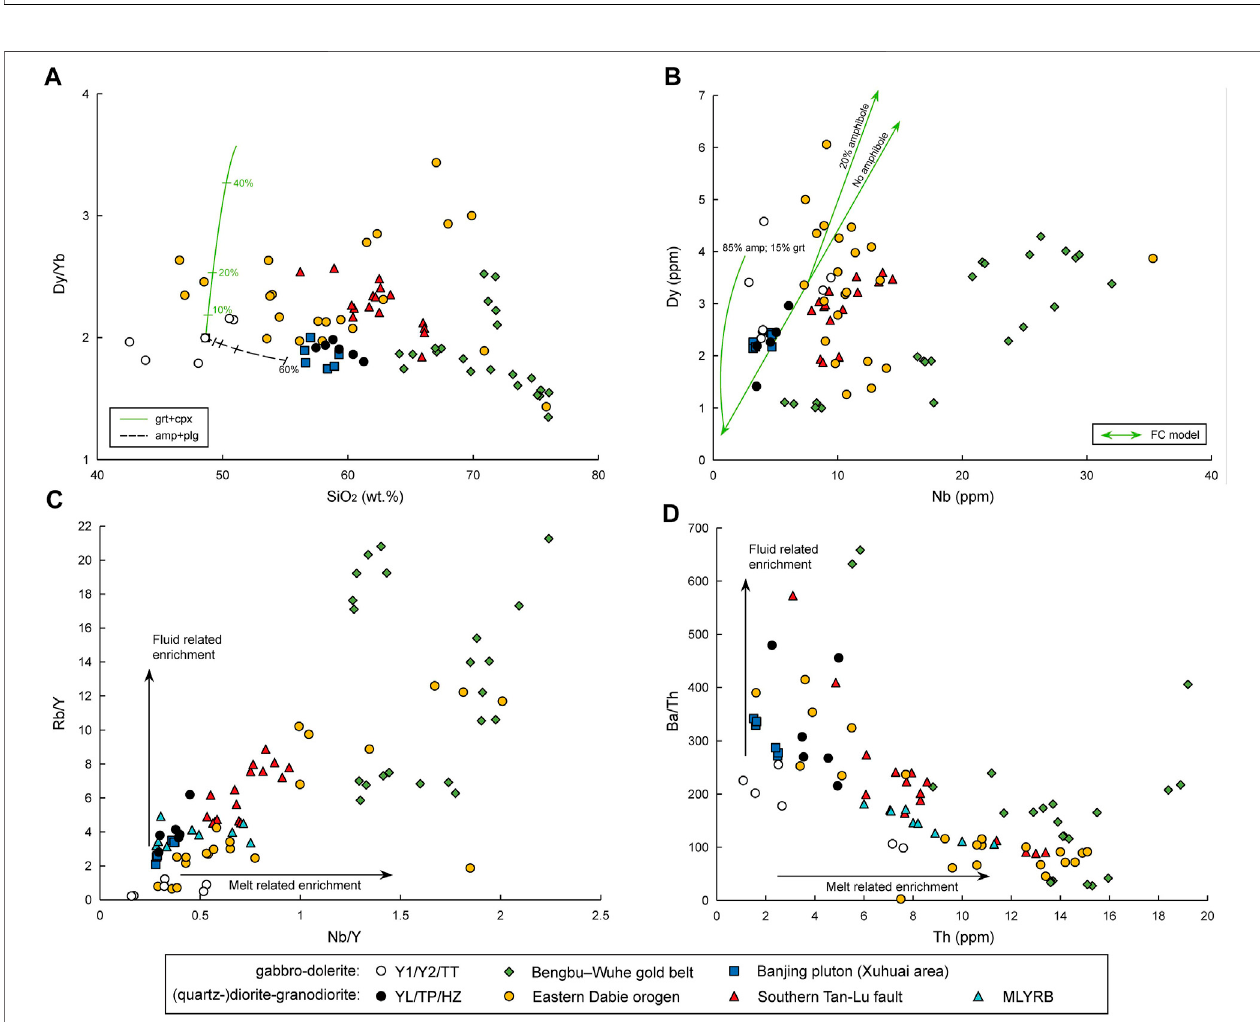
FIGURE 10 | (A – B) Trace element plots for identifying amphibole – garnet fractionation: (A) Dy/Yb vs. SiO 2 . Model fractionation paths are from Davidson et al. (2007),Macpherson (2008); (B) Dyvs.Nb; (C) Nb/Ta vs. Nb. Fractional crystallization (FC)and assimilation-fractional crystallization (AFC) trends arefrom Gómez-Tuena et al. (2007); (C – D) Trace element plots for differentiating fl uid-related vs. melt-related enrichments (after Zhao et al., 2020): (C) Rb/Y vs. Nb/Y; and (D) Ba/Th vs. Th. Abbreviations: amp (cid:1) amphibole; cpx (cid:1) clinopyroxene; grt (cid:1) garnet, pl (cid:1) plagioclase.